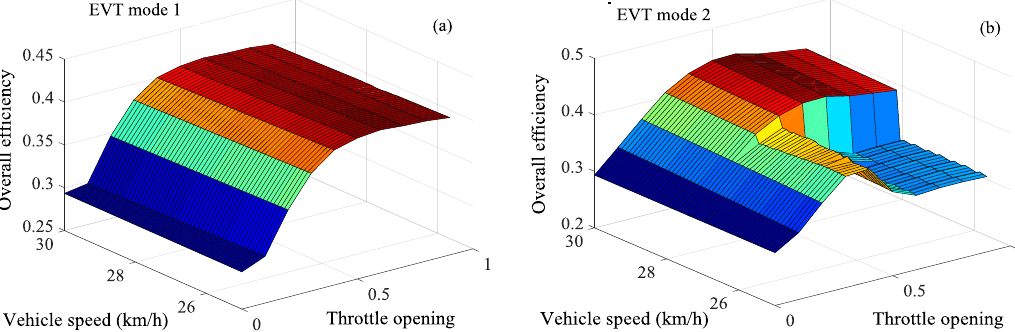
Figure 11. Overall efficiency for the hybrid HDV for each mode: ( a ) overall efficiency for EVT Mode 1; and ( b ) overall efficiency for EVT Mode 2.